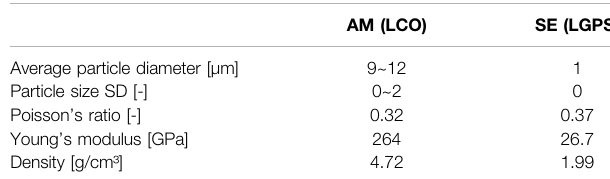
TABLE 1 | Calculation conditions for